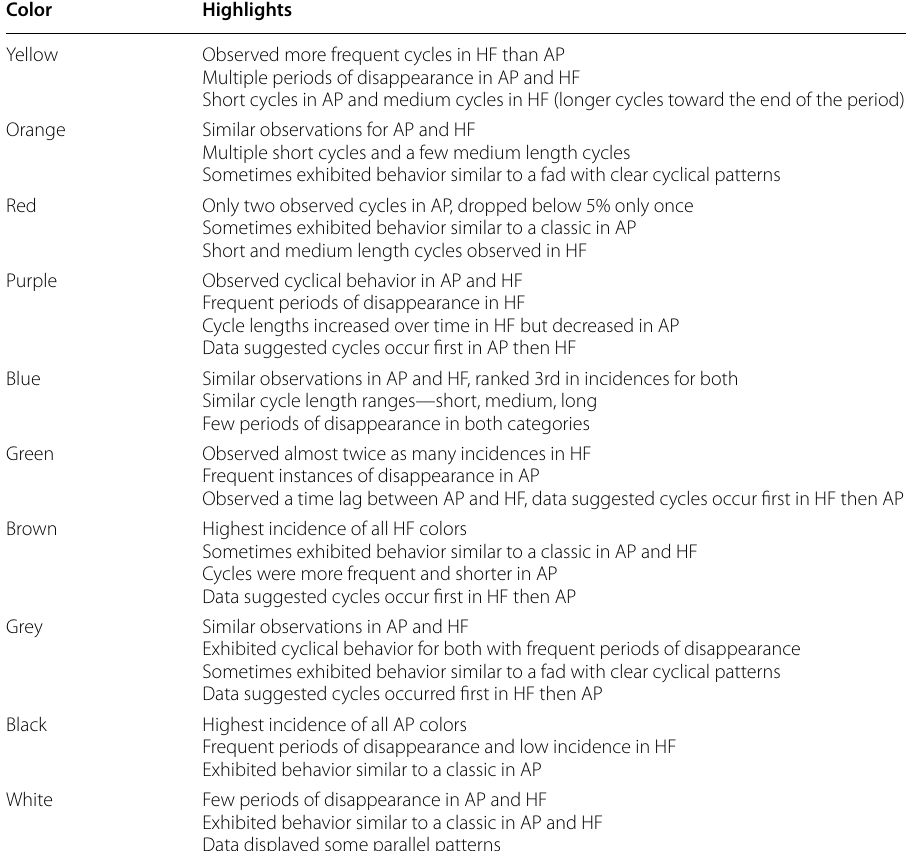
Table 2 Findings highlighted by color for apparel and home furnishings Color Highlights